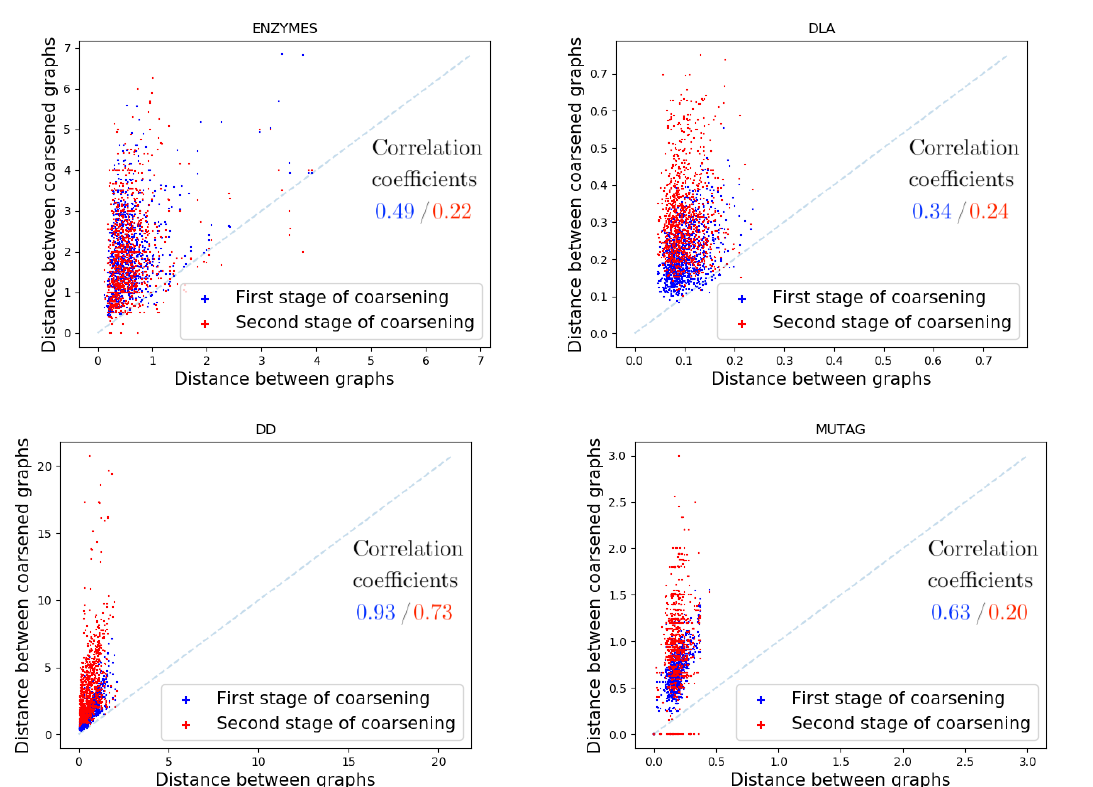
Figure 4. Wasserstein distance between spectra of graphs g 0 and h 0 sampled from different datasets (see Section 5 for their description) compared to the same distance between their coarsened graphs g 1 and h 1 and their two times coarsened graphs g 2 and h 2 . In blue (resp. red) are given the correlation coefficients of the distance between g 0 & h 0 and g 1 & h 1 (resp. g 2 & h 2 ). These coefficients have been computed after averaging 10 runs where we sampled 1000 graphs couples ( g 0 , h 0 ) for each dataset. As expected the more we coarsened graph the more the correlation coefficient decreases because coarsening always lost some structural